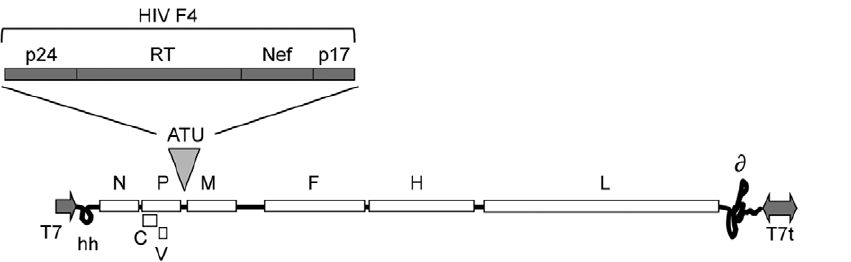
Figure 7. MV vector with ATU in positions 2 and 3. MV genes indicated are: N, nucleoprotein); PVC, phoshoprotein and V/C accessory proteins; M, matrix; F, fusion; H, hemagglutinin; L, polymerase; T7, T7 RNA polymerase promoter; hh, hammerhead ribosyme; T7t=T7 RNA polymerase terminator.